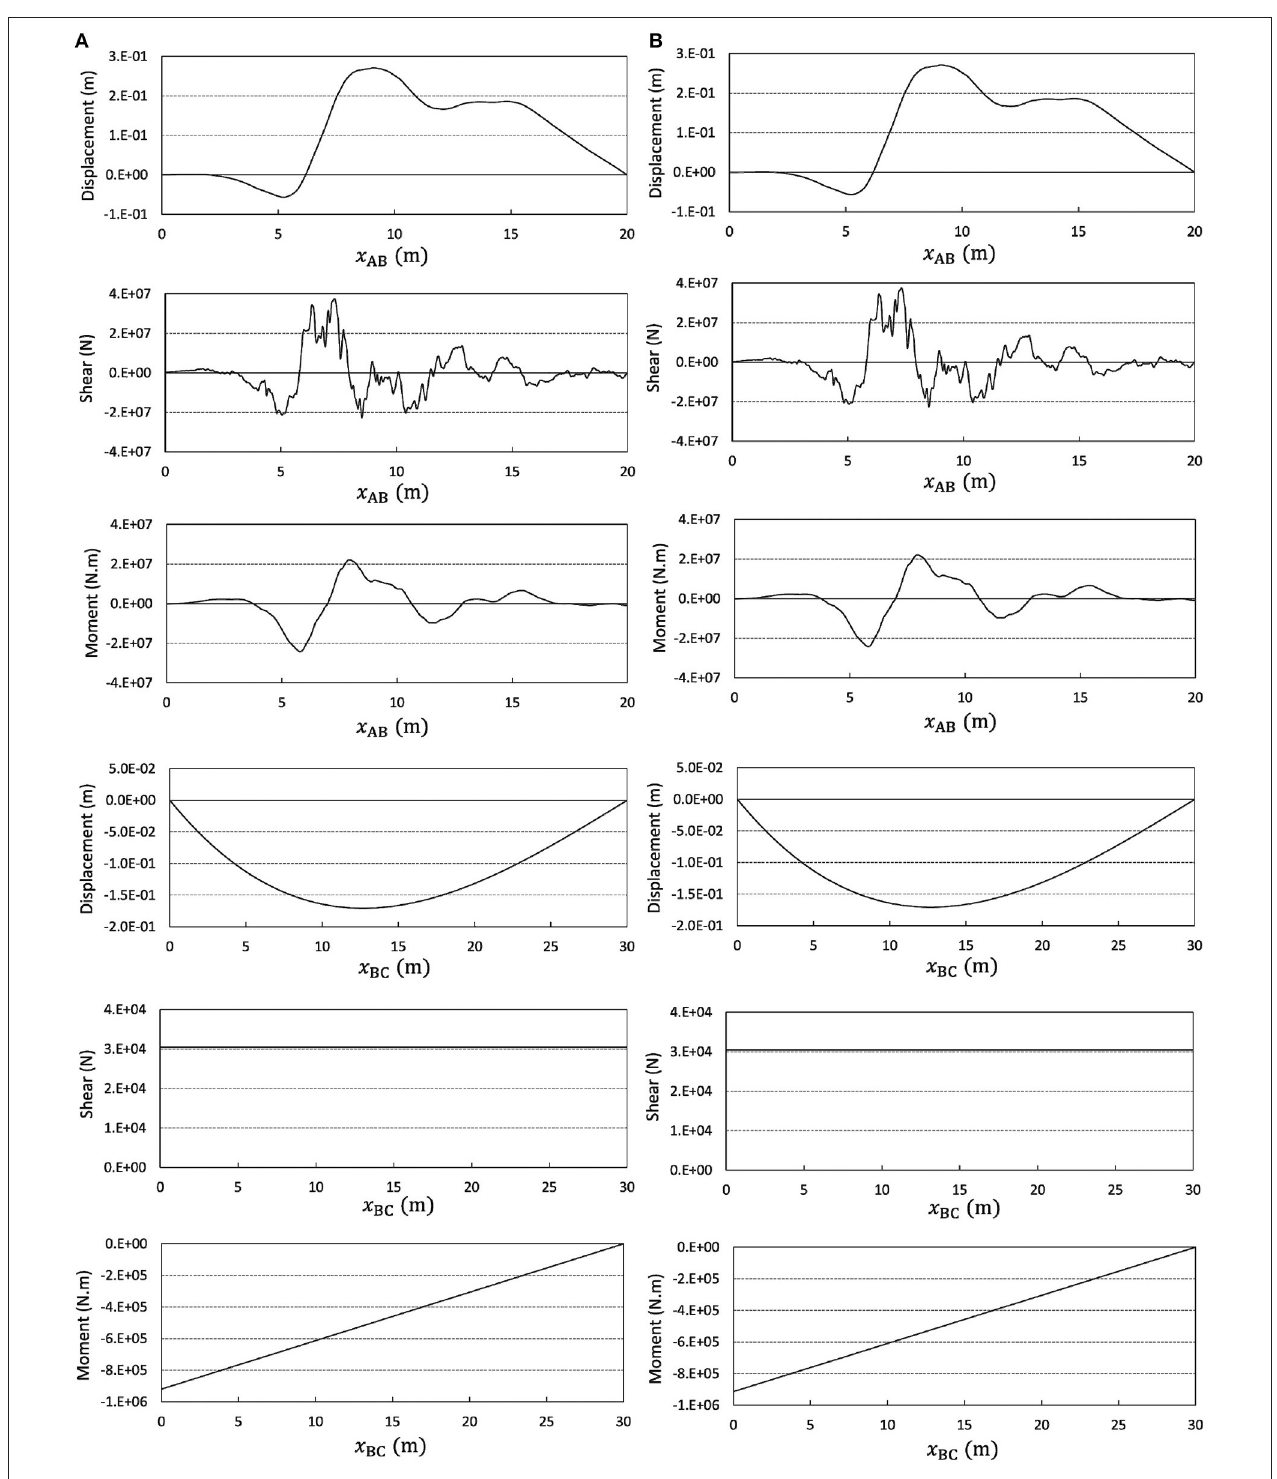
FIGURE 5 | Responses of the second example obtained from analysis with elements sized (A) f 1 x and (B) 3 f 1 x .